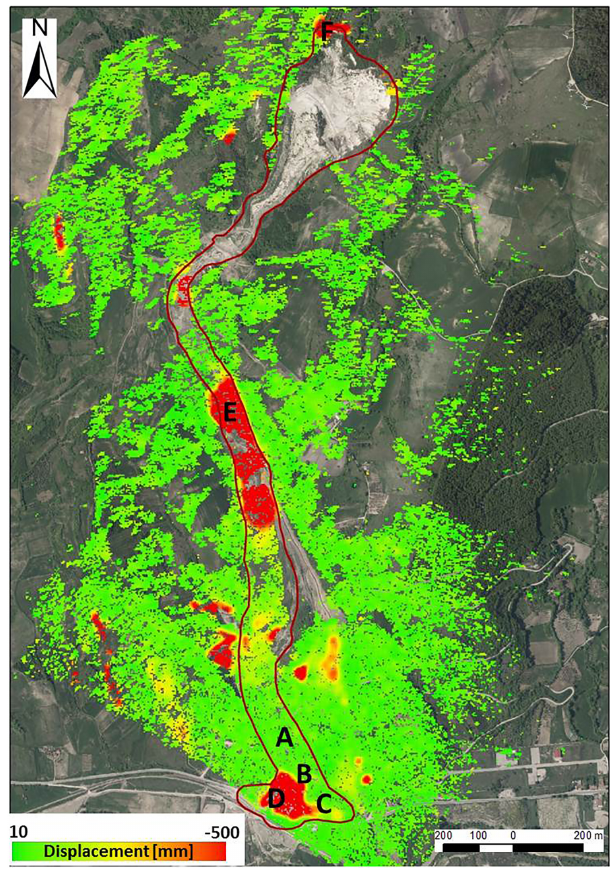
Figure 7. Monthly cumulated displacements (mm) map recorded between 1 and 31 March 2011. Negative values indicate movement towards the instrument.